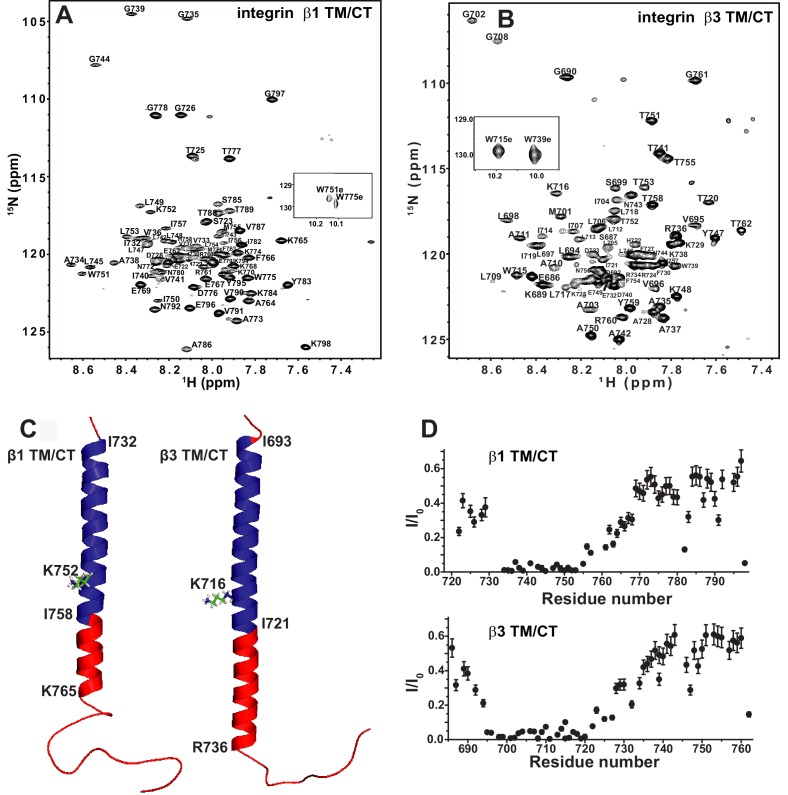
The β1 and β3 transmembrane and cytosolic domains have distinct structures.(A) 800 MHz 1H-15N TROSY spectrum of the WT integrin β1 TM/CT with peak assignments shown. This spectrum was collected at 45°C and the sample contains 500 µM β1 TM/CT (0.57 mol%), 20% q = 0.3 D6PC-DMPC bicelles, 1 mM EDTA, 250 mM IMD at pH 6.5% and 10% D2O. (B) 900MHz 1H-15N TROSY spectrum of the WT integrin β3 TM/CT with peak assignments shown. This spectrum was collected at 45°C and the sample contained 300 µM β3 TM/CT, 20% q = 0.3 D6PC-DMPC bicelles, 1 mM EDTA, 250 mM IMD buffer at pH 6.5, with 10% D2O. (C) Structural comparison of integrin β1 and β3 TM/CT in D6PC/DMPC bicelles. These structural models are based on backbone dihedral angles as determined by TALOS-N and chemical shift index analysis of backbone NMR chemical shift values. The figure was made in PYMOL. As described in the results section, the CT segments of the helices observed for both β integrins appear to be subject to significant dynamic fraying. (D) Assessment of exchange of protons between backbone amide sites and water at 100 msec, as determined by the CLEANEX-PM NMR experiment. Sites with low peak intensities after the 100 msec mixing period relative to control conditions (I/I0) are resistant to hydrogen exchange, while sites with high I/I0 values exchange rapidly on the time scale of 100 msec.